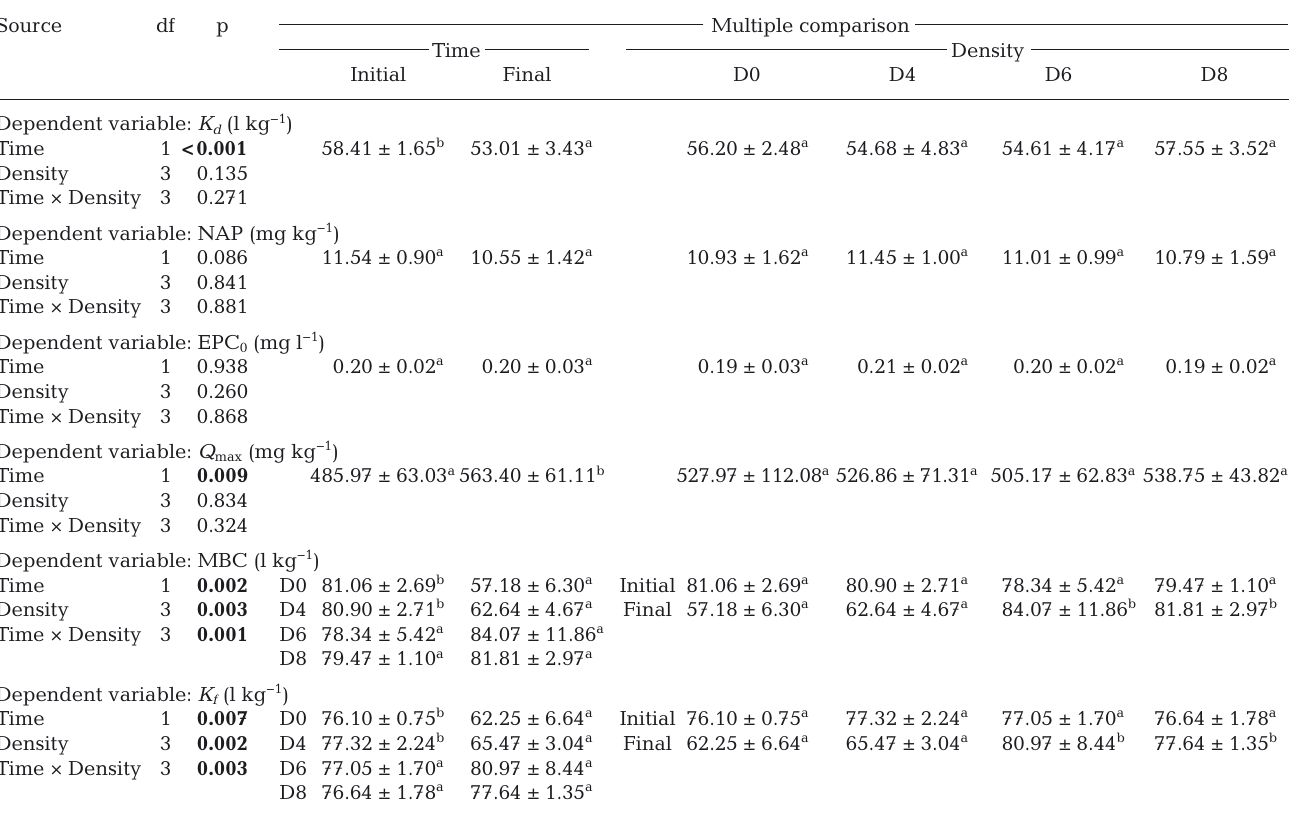
Table 4. Two-way factorial ANOVA for the phosphorus sorption parameters in sediment of different density groups of sea cucumbers Aposticho pus japonicus . K d : linear adsorption coefficient, NAP: native absorbed phosphorus, EPC 0 : equilibrium phosphorus concentration, Q max : phosphorus sorption maximum, MBC: maximum buffer capacity, K f : energy adsorption. Initial: Week 0; final: Week 12. Other details as in Tables 1 &